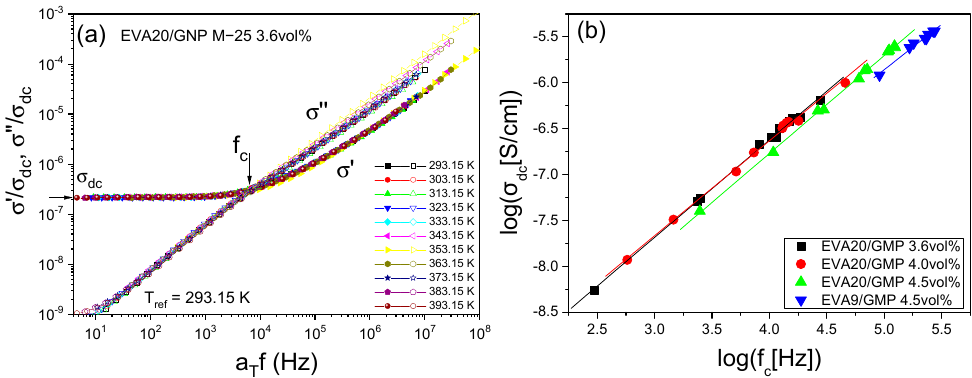
Figure 6. ( a ) AC conductivity master plot for the data of EVA with 3.6 vol% GNP in the temperature range 293.15–393.15 K. The isotherms superpose rather well over the isotherm of reference, by using the same horizontal and vertical shift factors for both σ ’ and σ ’’. The crossing frequency was used for extracting fc before shifting. ( b ) BNN plot: log σ dc vs log(f c ) for the graphene composites as indicated. The solid lines are linear regressions of the data (all linear coefficients 1.00 ± 0.02).